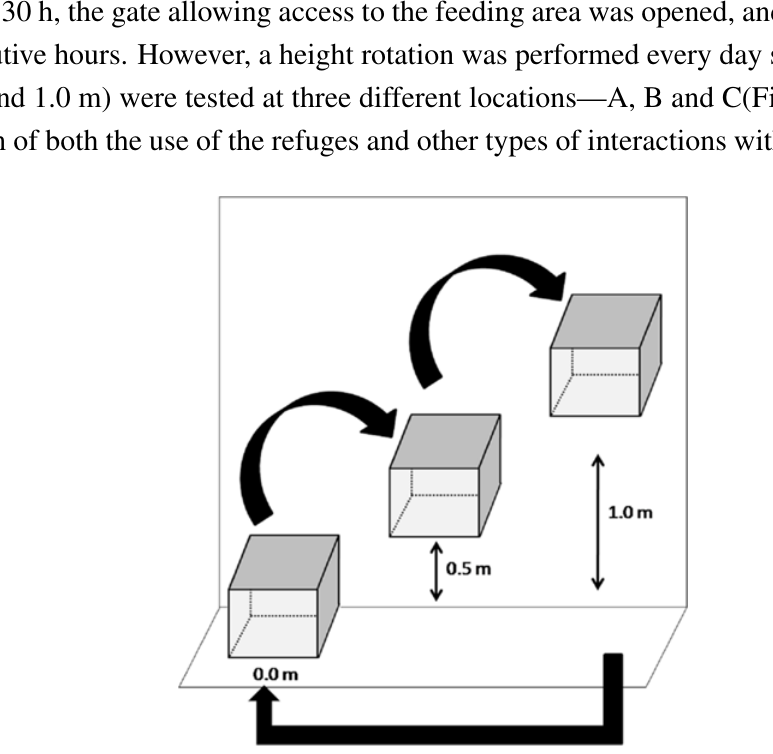
Figure 2. Diagram of the experimental set up of Experiment II. The arrows represent rotation of the boxes in three different positions at the wall, applied to each day of testing.